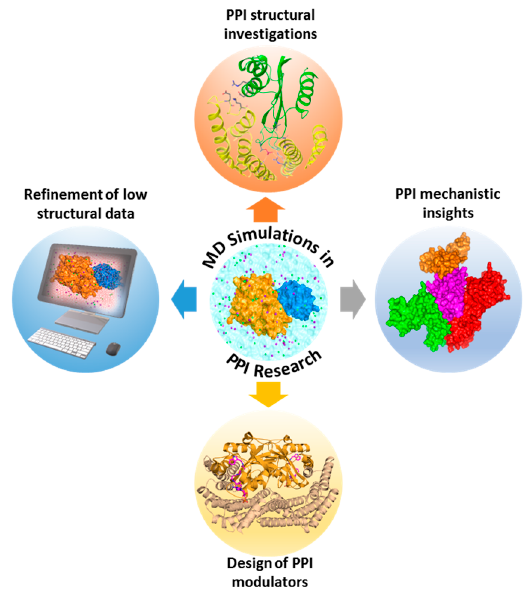
Figure 3. Varied applications of molecular dynamics (MD) simulations in PPI research. Using MD simulations, several aspects of PPIs can be explored, such as gaining insights into their structural, functional, and mechanistic processes, design of PPI inhibitors or stabilizers, and refinement of PPI structures with lower resolutions.